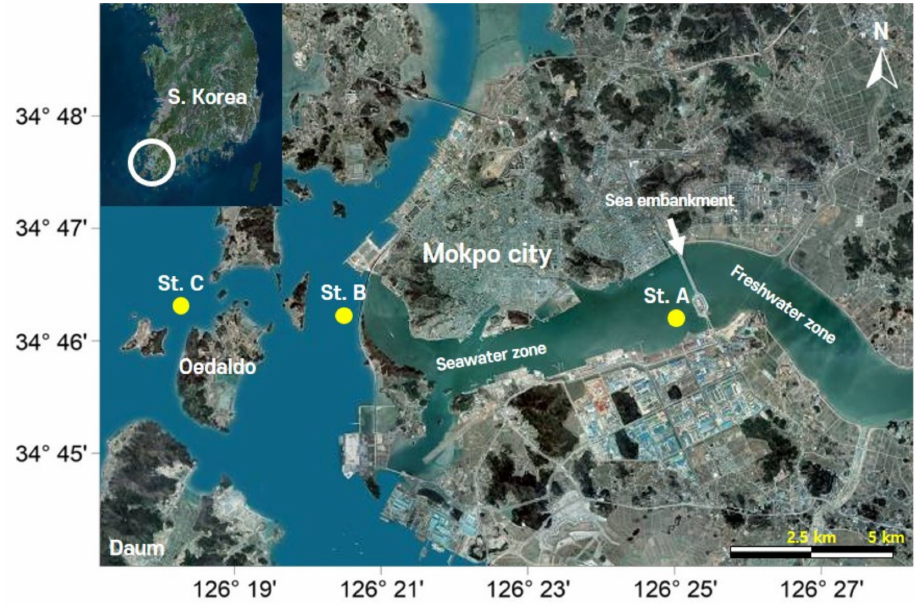
Figure 1. Field data collection sites in the Youngsan River estuary (South Korea). The aerial images were obtained from DAUM (www.daum.net) (accessed on 18 June